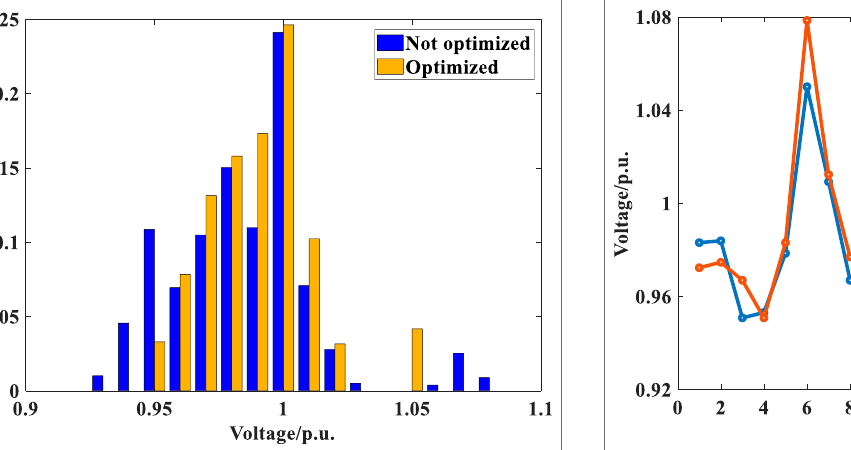
FIGURE 14 | The voltage profile (p.u.) of the network with the random or optimized ESS placement at peak time (time step